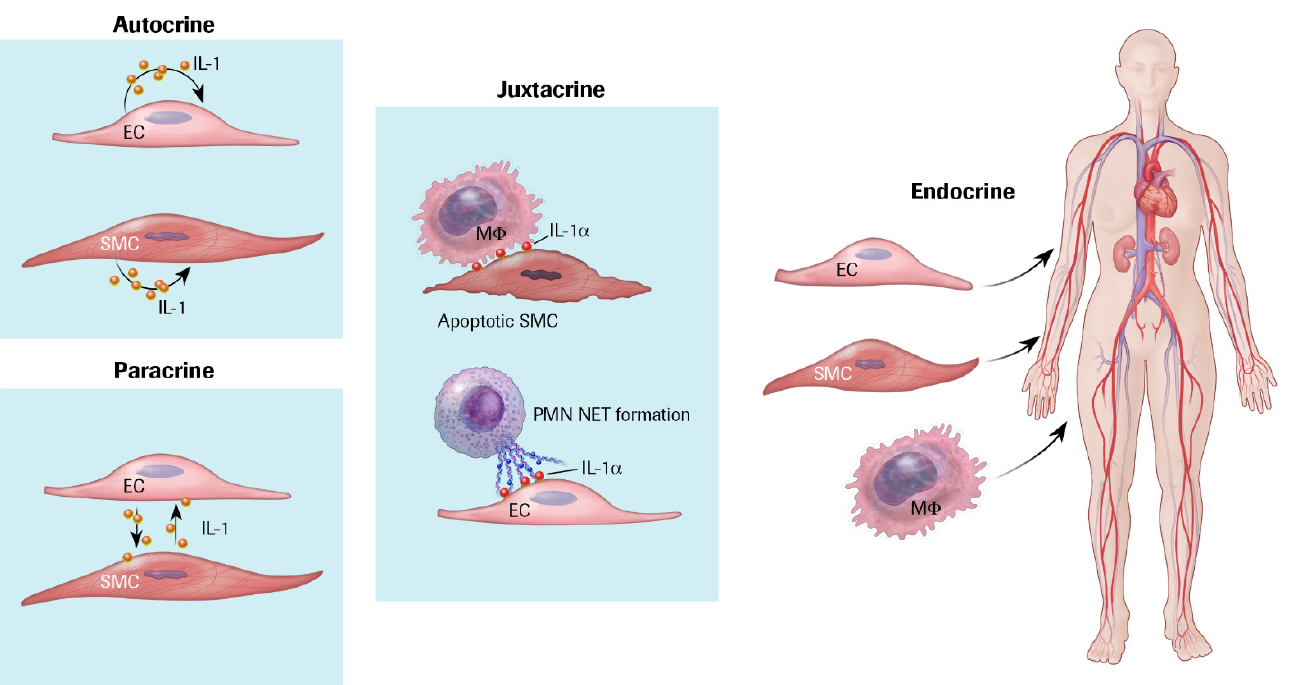
Figure 2. Cytokines can act through autocrine, paracrine, juxtacrine, or endocrine pathways. Cytokine signaling can operate in different ways. Autocrine signaling, shown on the upper left, can involve IL-1-induced IL-1 expression. Paracrine signaling denotes exchange of cytokines such as IL-1 between neighboring cells as exemplified here by endothelial cell and smooth muscle cell crosstalk. Juxtacrine signaling involves cell contact. Two examples pertinent to cytokine signaling in vascular pathophysiology include IL-1 α expressed on the surface of smooth muscle cells that are activated or are undergoing death. IL-1 α can signal to macrophages by contact. IL-1 α also associates with neutrophil extracellular traps (NETs) and can activate endothelial cell pro-inflammatory functions such as adhesion molecule expression and tissue factor generation in a manner that requires contact. Finally, the circulation can carry secreted cytokines to distant organs, denoted endocrine signaling. For example, IL-6 secreted by vascular cells as well as leukocytes can circulate to encounter hepatocytes and trigger the acute phase response as shown in Figure 3.